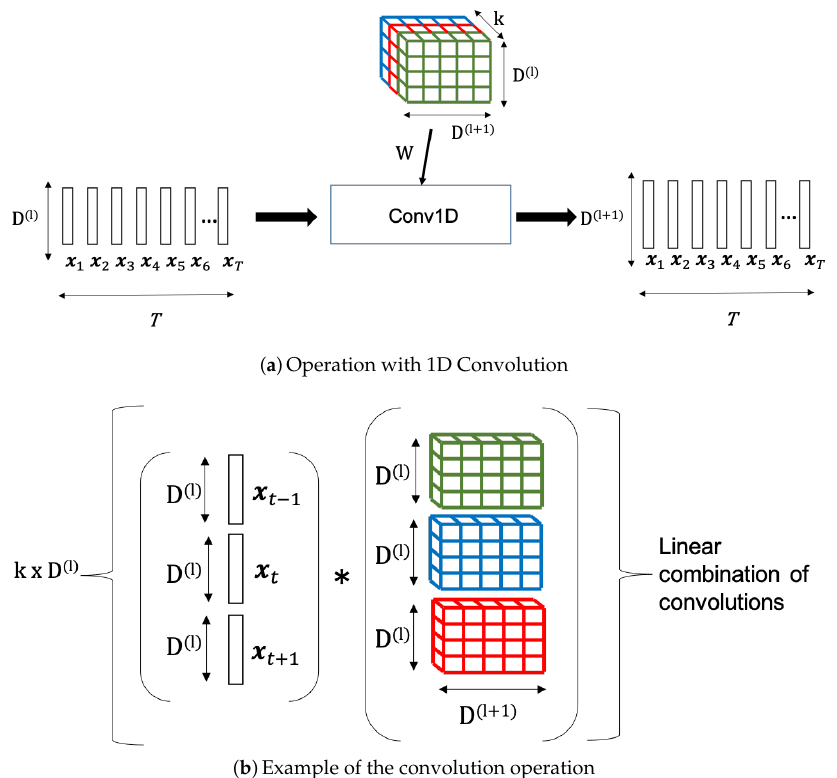
Figure 2. Operation with 1D Convolution layers, ( a ) general pipeline of this operation; ( b ) example of how k context frames from input are multiplied by the weight matrix W and the output is equivalent to a linear combination of